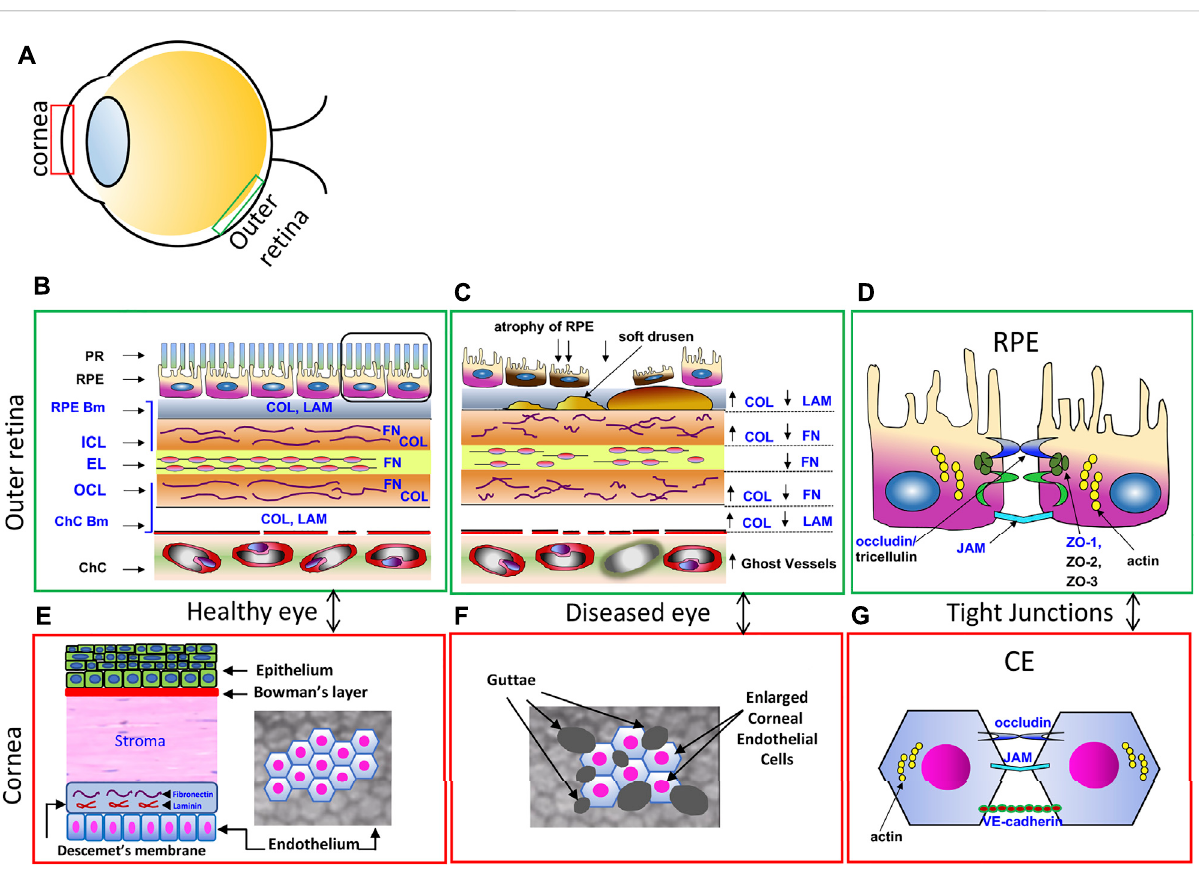
FIGURE 1 Comparisons of the RPE Monolayer and the Corneal Endothelial Monolayer. (A) Schematic diagram showing the location of the cornea and outer retina. (B) Enlarged diagram of the healthy outer retina in cross section, with photoreceptor outer segments (PR), retinal pigment epithelium (RPE) and underlying Bruch ’ s Membrane, an extracellular matrix that includes the RPE basement membrane (RPE Bm), the internal collagenous layer (ICL), elastic layer (EL) and outer collagenous layer (OCL) and the choroicapillaris (ChC) basement membrane (ChC bm). These layers contain collagen (Col), laminin (LAM), fi bronectin (FN), substrates of GrB. Adapted from Matsubara et al., 2020. (C) In the AMD diseased eye, the ECM is disorganized;COL,FNandLAMarecleavedbyGrB,causingaredistributionofECM proteins.Soft drusendepositsdevelop, causing RPEatrophy and eventually cell death. (D) Tight junctional proteins between RPE support the outer blood eye barrier in the healthy eye. ZO-1, occludin, and JAM are substratesofGrBandaresusceptibletoGrBcleavage. (E) Enlargeddiagramofthehealthycornealepithelium,stomaandcornealendothelium(CE)in cross section (left) and in fl atmount views (right). Descemet ’ s membrane, an ECM, contains FN and LAM. (F) In the FECD diseased eye, the CE are enlarged with guttae deposits shown in the fl atmount view. (G) Schematic diagram of the junctional proteins, occludin, JAM, and VE-cadherin, between CEC support the barrier